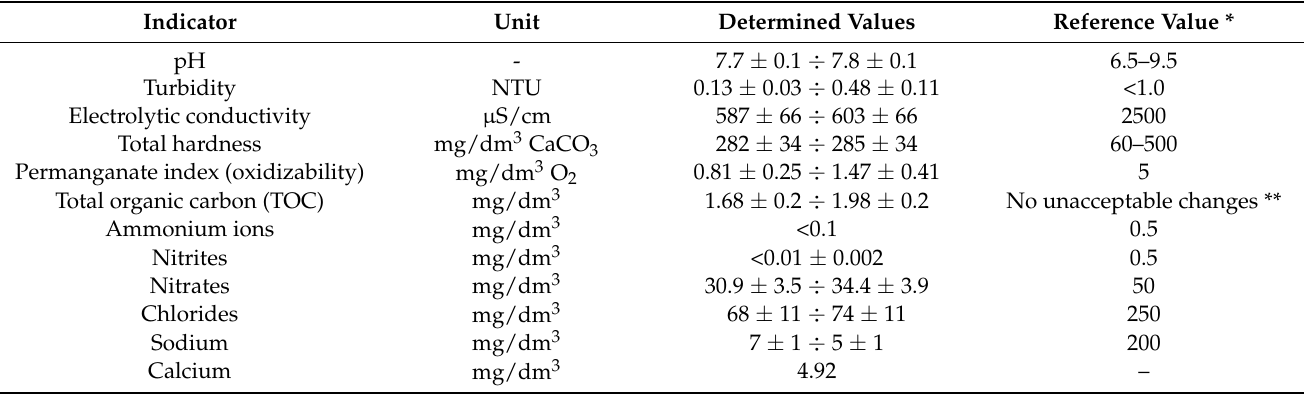
Table 2. Physical and chemical indicators of the tested water along with the permissible values of pollutants in surface